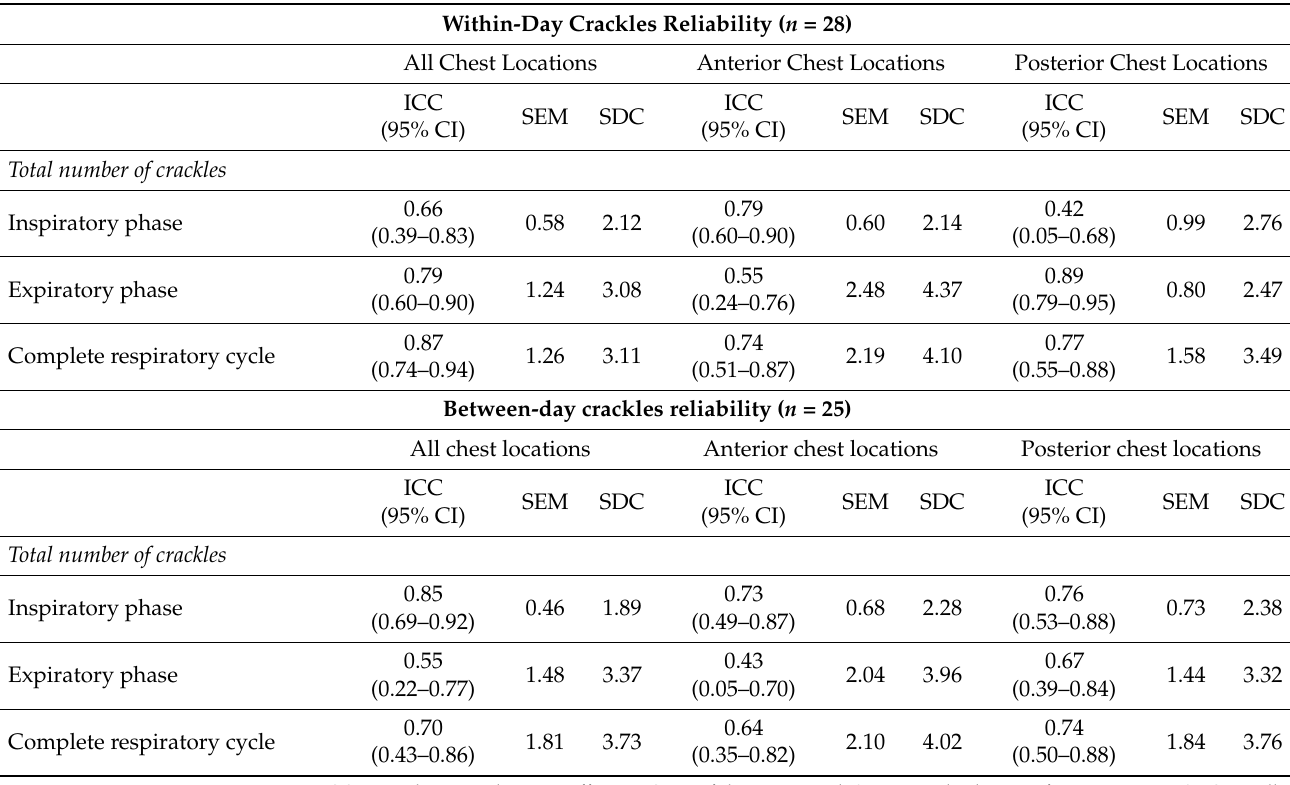
Table 2. Within-day and between-day reliability of crackles during the inspiration, expiration and complete respiratory cycle and per chest